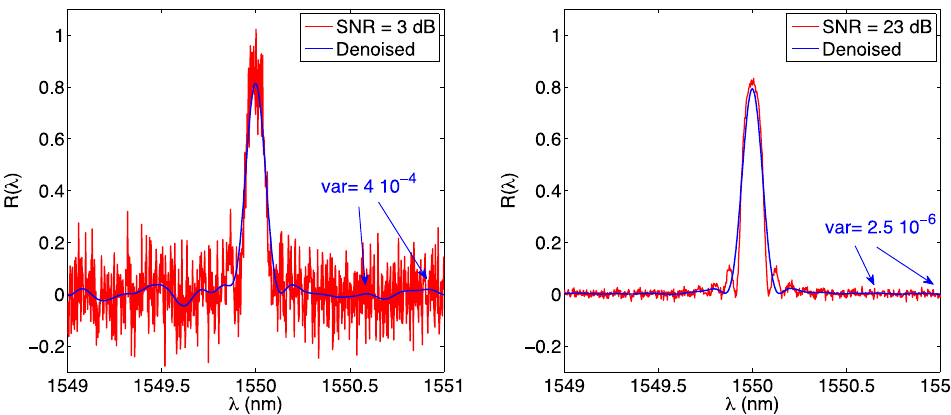
Figure 25. Effect of wavelet denoising on a FBG spectrum sampled over 1 pm wavelength grid. ( left chart ) SNR = 3 dB; ( right chart ) = 23 dB. Denoising has been performed with db3 wavelet.